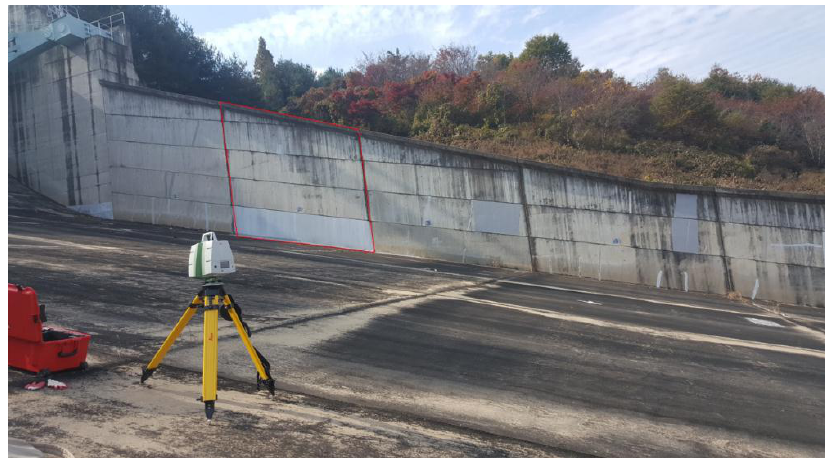
Figure 8. The panoramic view of TLS measurement set-up.